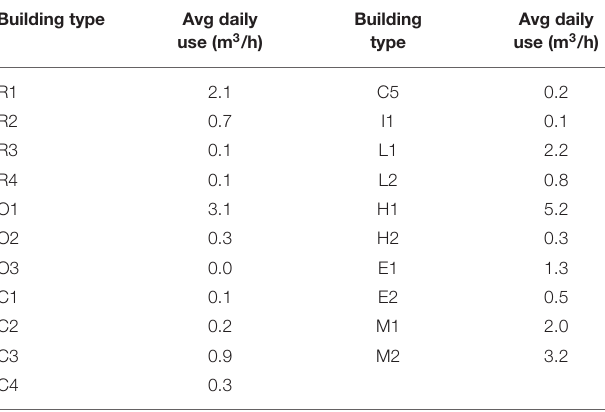
TABLE 2 | Average daily water use for all the 21 building